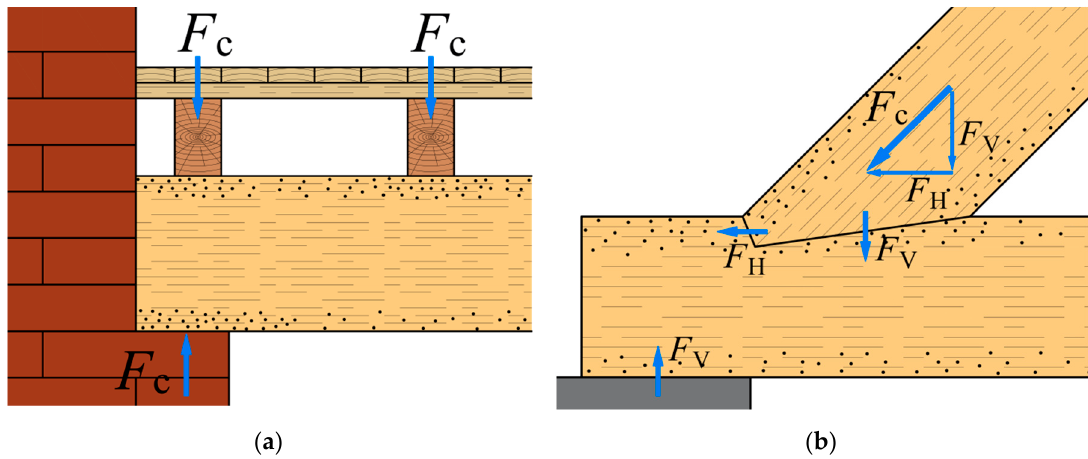
Figure 1. Insect-deteriorated timber members withstanding compressive loads ( F c ), implying their vertical ( F V ) and horizontal ( F H ) components in connections: Main floor beam in contact with masonry support ( a ), single step joint within roof trusses ( b ). Black dots represent exit holes on the external surfaces of wood infested by insects.